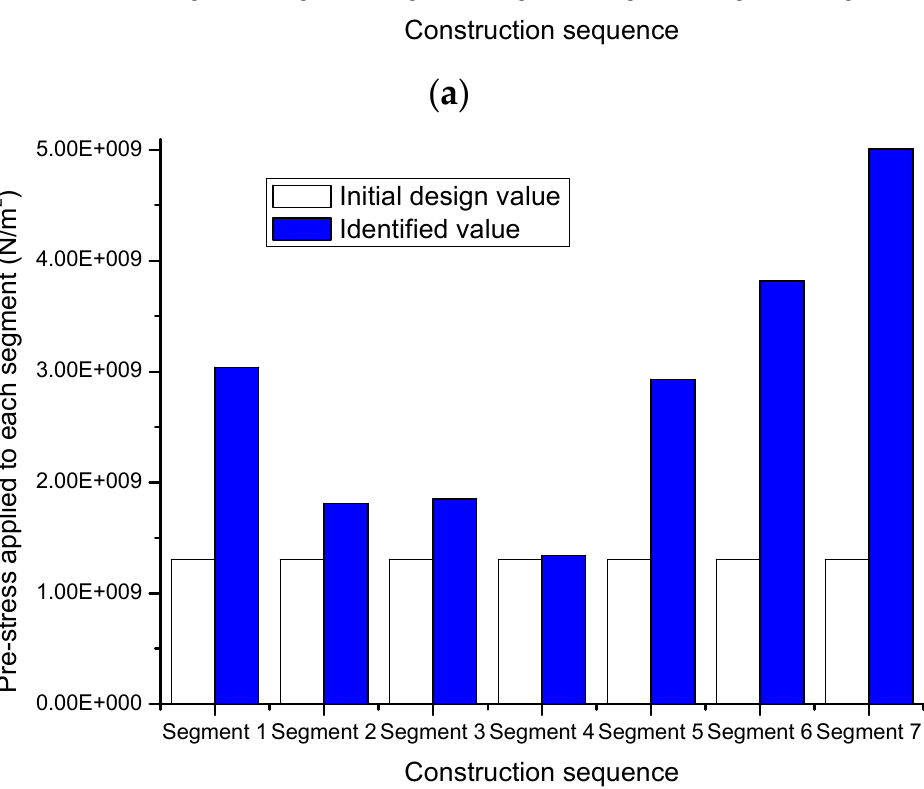
effectiveness of the proposed model updating practice. In addition, the stress sequences calculated using the initial model without model updating are also added in Figure 12. As can be seen, the numerical results for the initial FE model are noticeably smaller than the full ‐ scale measurement data, suggesting that the structural analyses utilizing the FE model with design parameters might lead to unsafe results.